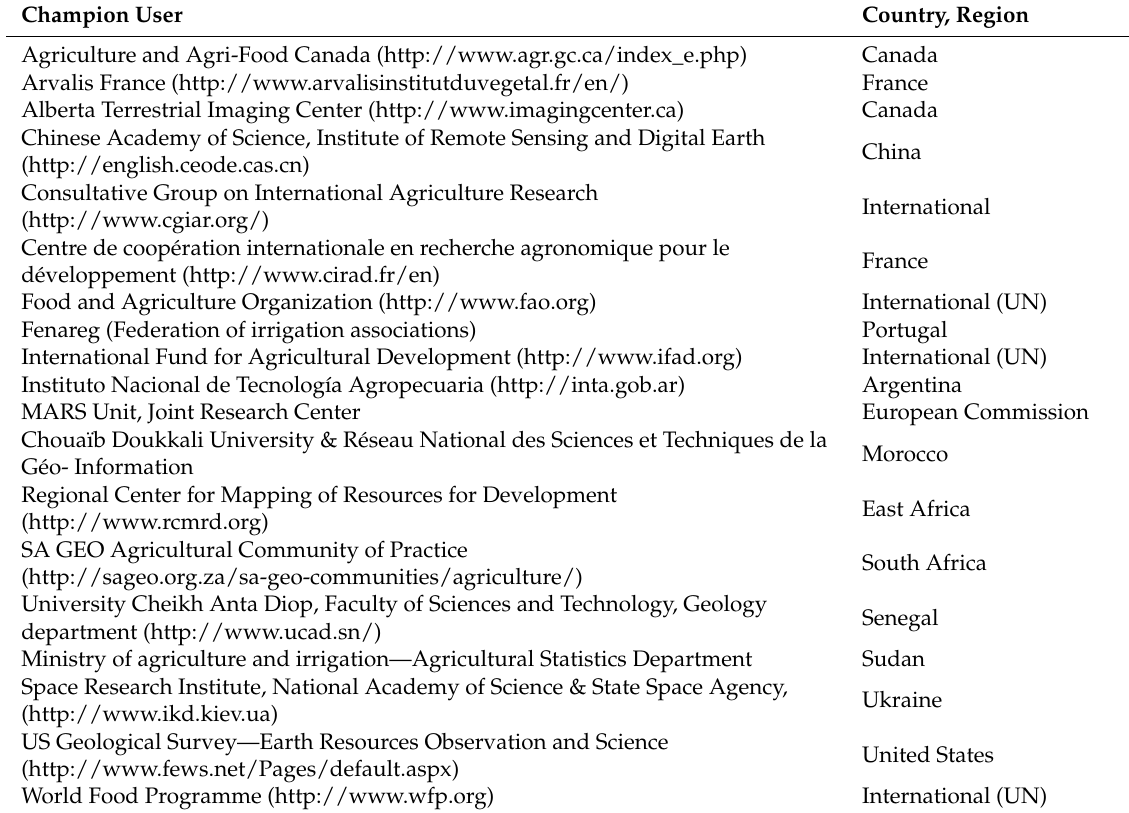
Table 2. “Champion Users” of the Sen2-Agri